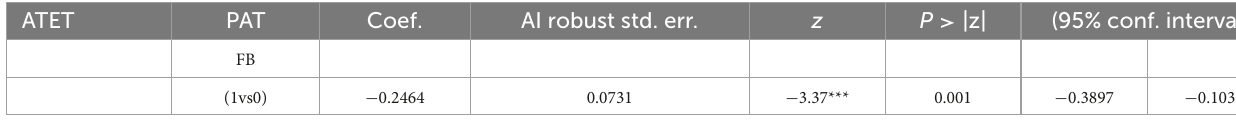
TABLE 7 Average treatment effect on the treated. ATET PAT Coef. AI robust std. err. z P > |z| (95% conf. interval) FB (1vs0) − 0.2464 0.0731 − 3.37*** 0.001 − 0.3897 − 0.1031 *** p <